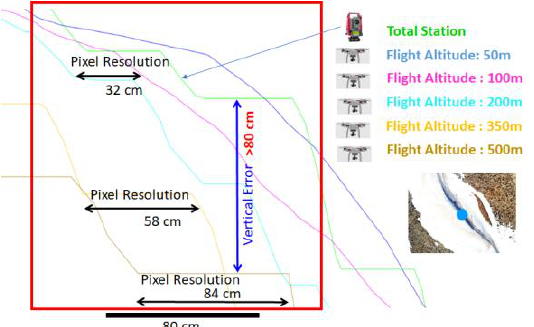
Figure 10: Comparison of altitude along the sample section extracted from Total Station and UAV at different altitude flight. The red rectangle represents the blue circle of the cornice location in Figure